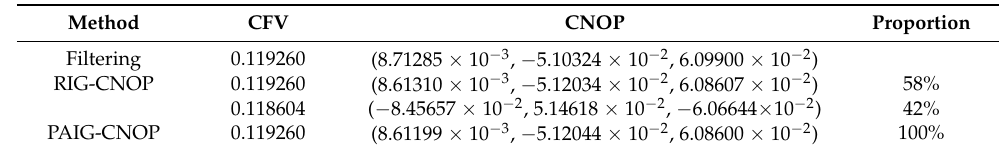
Table 4. Statistical analysis of the MCFVs corresponding to the CNOPS generated by the different methods at point C 1 , T = 400.